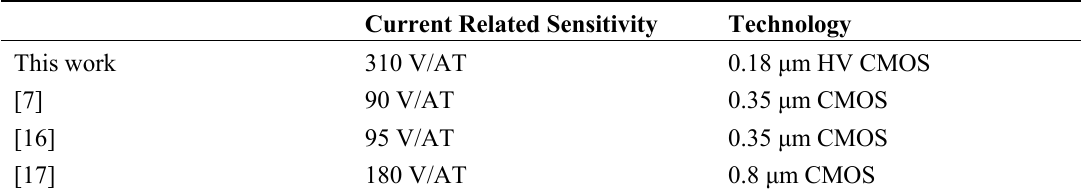
Table 1. Comparison of the current related sensitivity between the proposed single Hall device and the reported Hall devices.